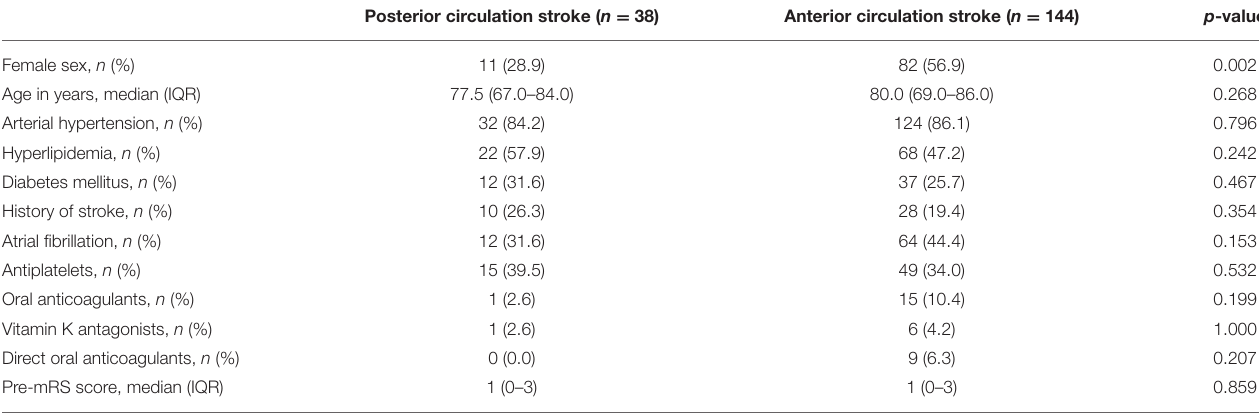
TABLE 1 | Baseline characteristics in the clinico-radiological patient cohort. Posterior circulation stroke ( n = 38) Anterior circulation stroke ( n = 144) p -value